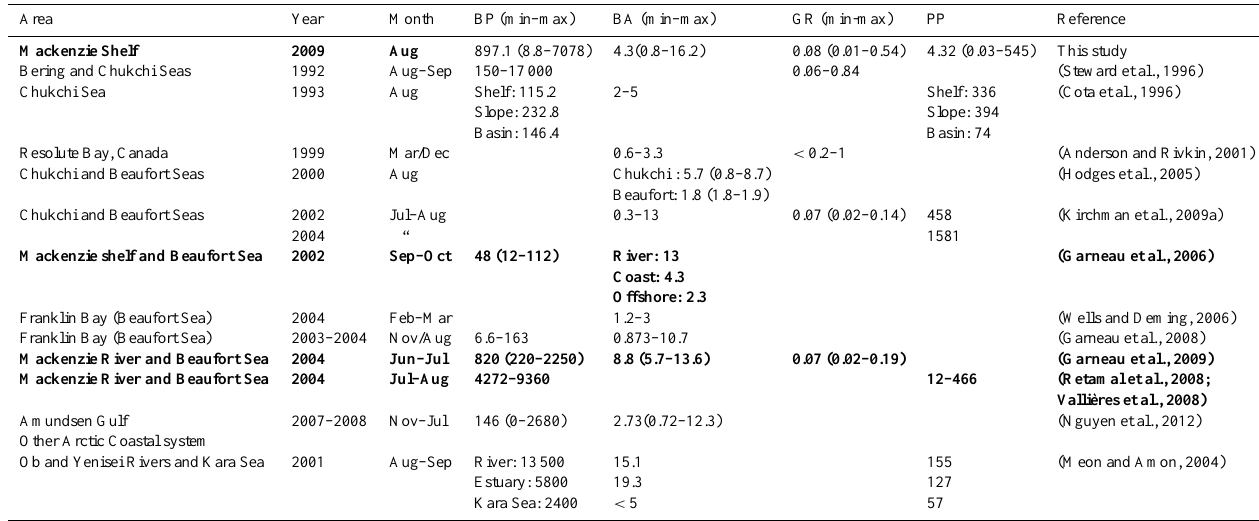
Table 4. Bacterial production (BP, µgCm − 3 d − 1 ) , abundance (BA, × 10 5 cellml − 1 ) growth rates (GR, d − 1 ) and primary production (PP, mgCm − 3 d − 1 ) reported in previous studies in the Western Arctic Ocean and a study in the coastal Eastern Arctic Ocean. Studies performed in the same location as the present study are highlighted in bold.